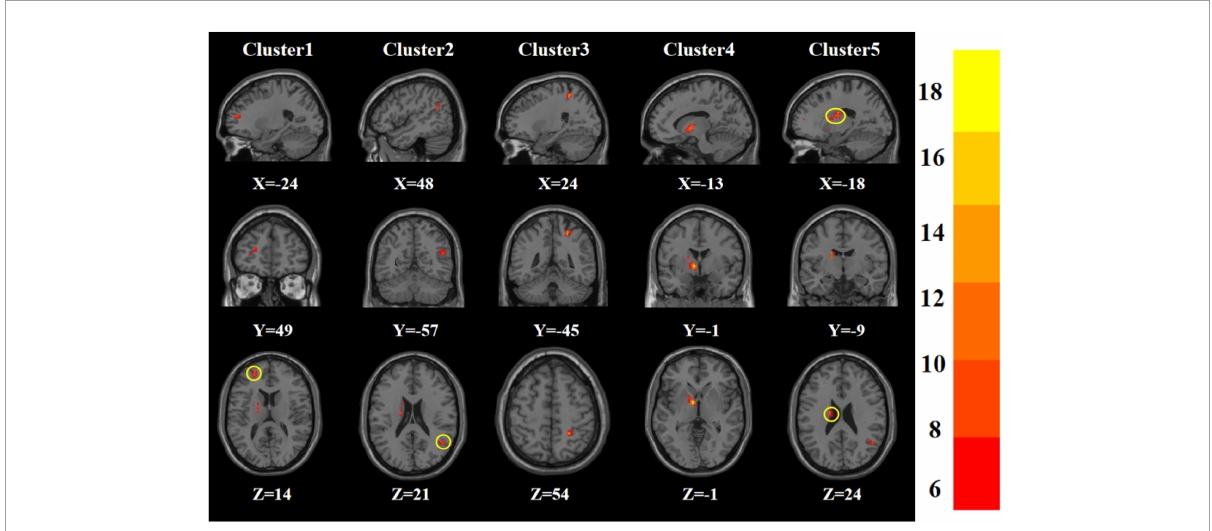
FIGURE1 Statistical maps showing ANOVA result of ALFF abnormalities among patients with younger TRD, older TRD group, younger HC group, and older HC group (GRF corrected). The color bars indicate the F -value.